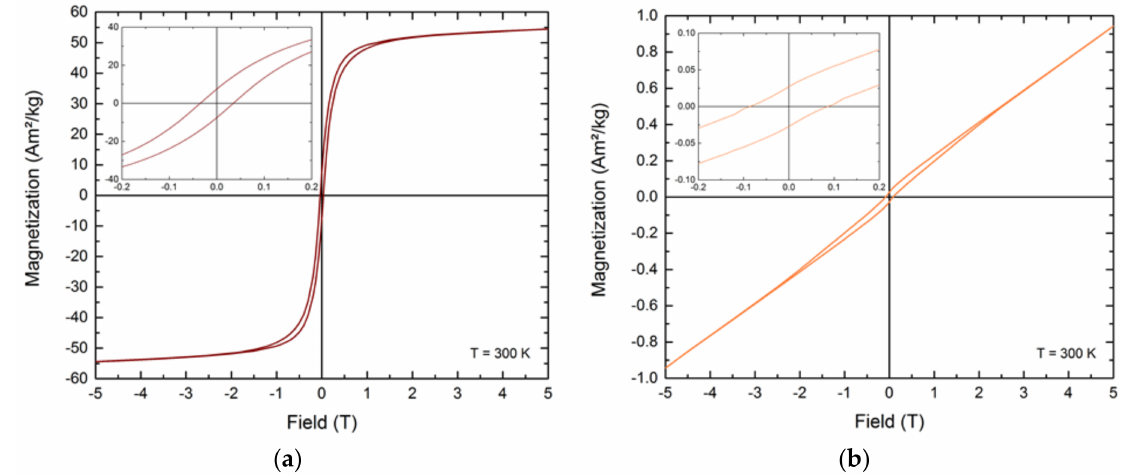
Figure 9. Magnetization curves of the predominantly ferromagnetic Fe 3 Pt ( a ) and paramagnetic FePt 3 nanocrystals ( b